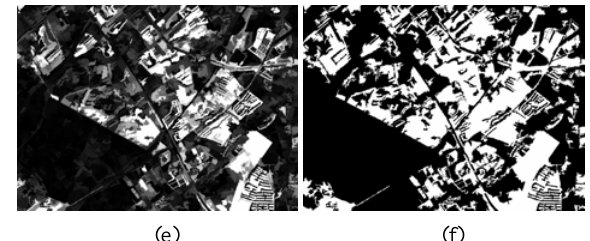
Figure.2 Examples of Change Detection with Multi-feature Synthesis (Chen, 2011) ， (a)Spot5 Image of Kunming in January, 2004 (b)QuikBird Image of Kunming in May, 2006 ， (c)Segmentation Result of a, b